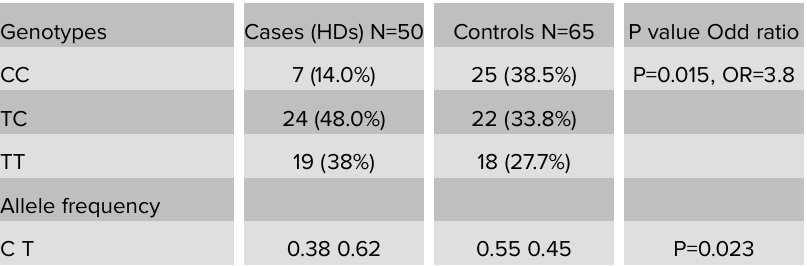
TABLE 3: Comparison of the genotypes and allele frequency of IL1β C > T (rs1143634) polymorphism between HD cases and controls.